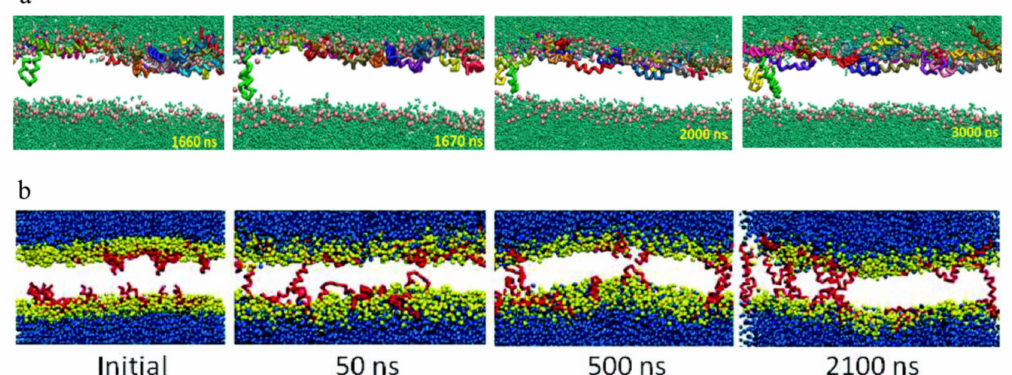
Figure 2. Two successful examples showing the membrane insertion process of melittin with di ff erent initial simulation conditions. ( a ) Transmembrane penetration of melittin into a DPPC / POPG membrane. P/L ∼ 1/21. Initially, peptides are adsorbed on the outer surface of the membrane. After 1600 ns, one U-shaped melittin penetrates into the bilayer and soon reaches the inner leaflet at 1670 ns. After that, aggregation occurs between the first and a second U-shaped peptide. Such aggregation further stabilizes the penetration state of melittin (e.g., 2000~3000 ns). Here, the peptides are colored di ff erently for ease of understanding. For lipids, the PO 4 groups are drawn in pink; while tails are not shown for clarity. Polarizable water is depicted in green. The figure is adapted with permission from [75], copyright 2013, American Chemical Society. ( b ) Translocation of melittin across a DPPC lipid bilayer at P/L ∼ 1/21. Initially, melittin peptides are adsorbed on both sides of the membrane. Some of the peptides insert into the membrane quickly (at 50 ns) in a U-shaped configuration. Then, multiple aggregates of peptides occur in the membrane interior (at 500 ns), and finally, transmembrane pores are formed (~2100 ns). Peptides are shown only by protein backbones (red). CG water molecules are shown as blue beads, while lipid headgroups as yellow beads. The figure is reprinted with permission from [76], copyright 2012, American Chemical